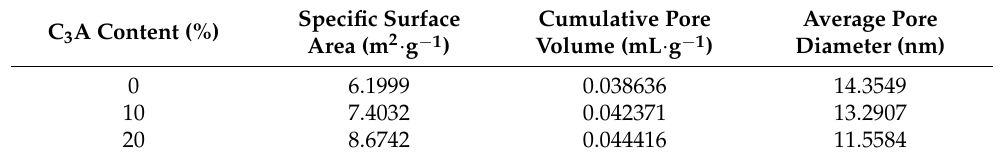
Figure 9. N 2 adsorption desorption isotherm of C 3 S-C 3 A paste.